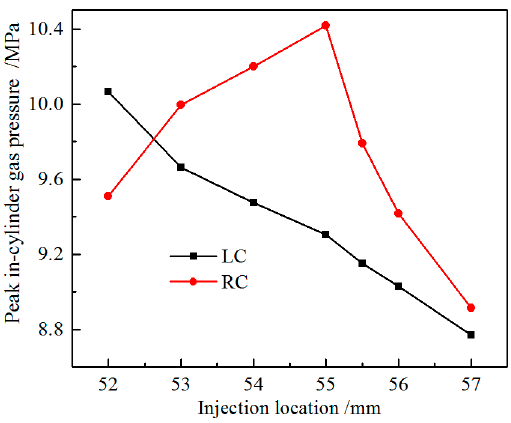
Figure 11. Peak in ‐ cylinder gas pressure variation for different values of the “triggering position”.